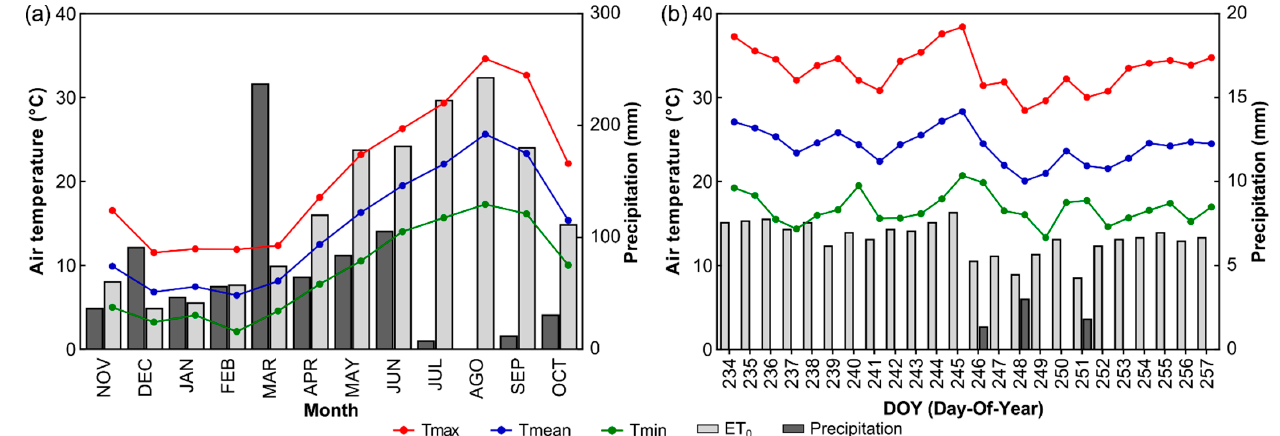
Figure 2. Monthly mean weather for the study area between November 2017 and October 2018 ( a ) and daily weather data for the period of the field study ( b ). Mean (T mean ), minimum (T min ) and maximum (T max ) air temperatures, precipitation and evapotranspiration (ET 0 ) values.